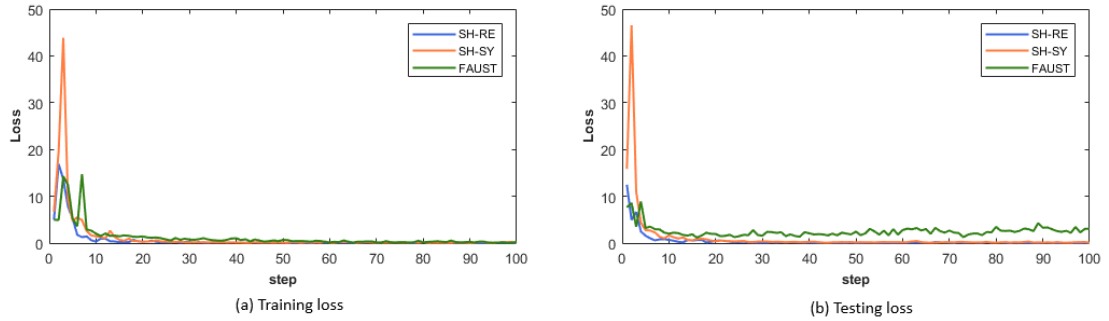
Figure 14. Training and testing losses of pose retrieval on the SH-RE, SH-SY, and FAUST